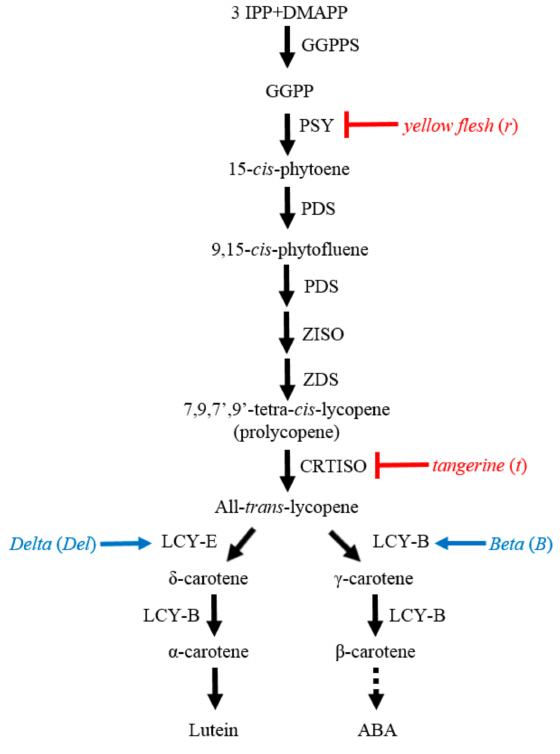
are represented in italics. Blue color indicates positive regulation and red color indicates negative regulation of carotenogenesis. CRTISO, carotene isomerase; DMAPP, dimethylallyl diphosphate; GGPP, geranylgeranyl diphosphate; GGPPS, geranylgeranyl diphosphate synthase; IPP, isopentenyl diphosphate; LCY-B, lycopene β -cyclase; LCY-E, lycopene ε -cyclase; PDS, phytoene desaturase; PSY, phytoene synthase; ZDS, ζ -carotene desaturase; ZISO, ζ -carotene